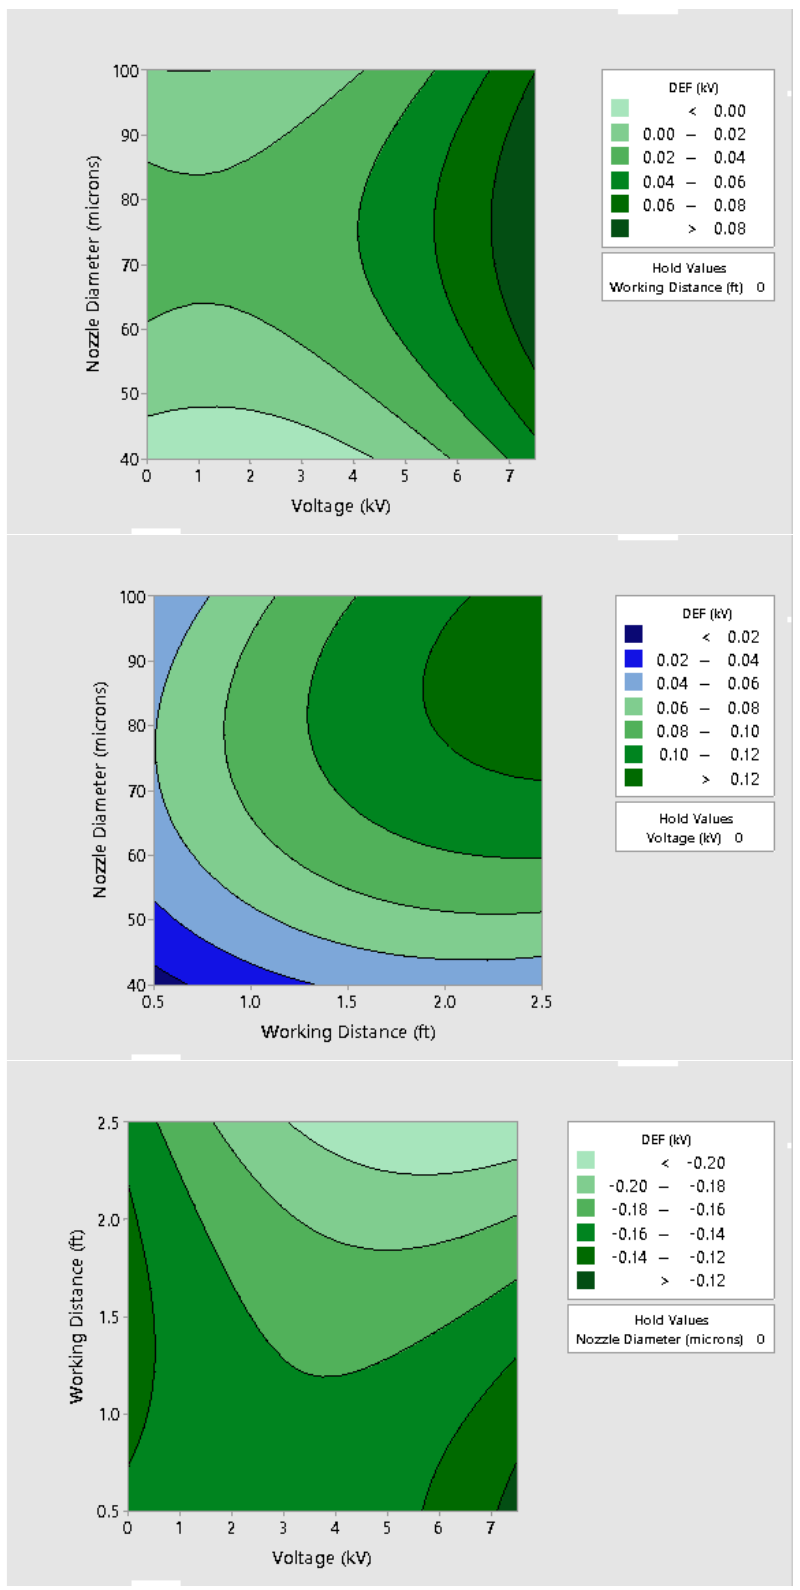
Figure A28. Aircraft sample-1: quantitative representation of average differential electric field vs. working distance (feet), nozzle sprayer size ( µ m), and charge voltage